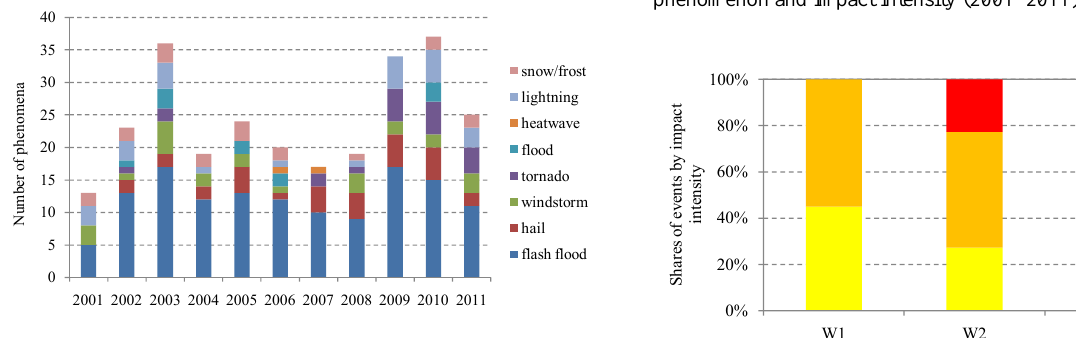
Fig. 9. Annual distribution of weather-related phenomena by type, for the period 2001–2011.